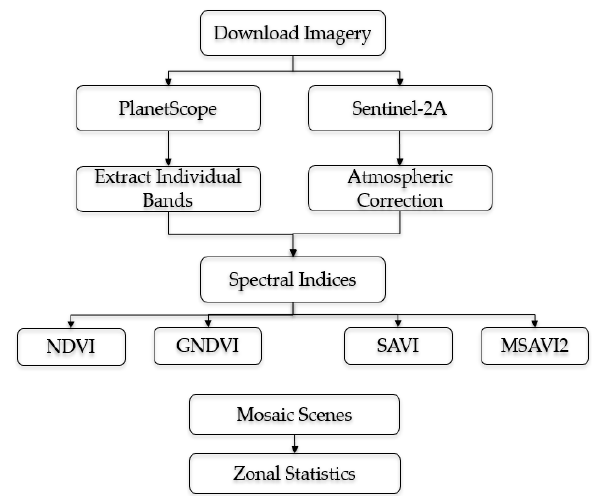
Figure 3. Satellite imagery processing workflow